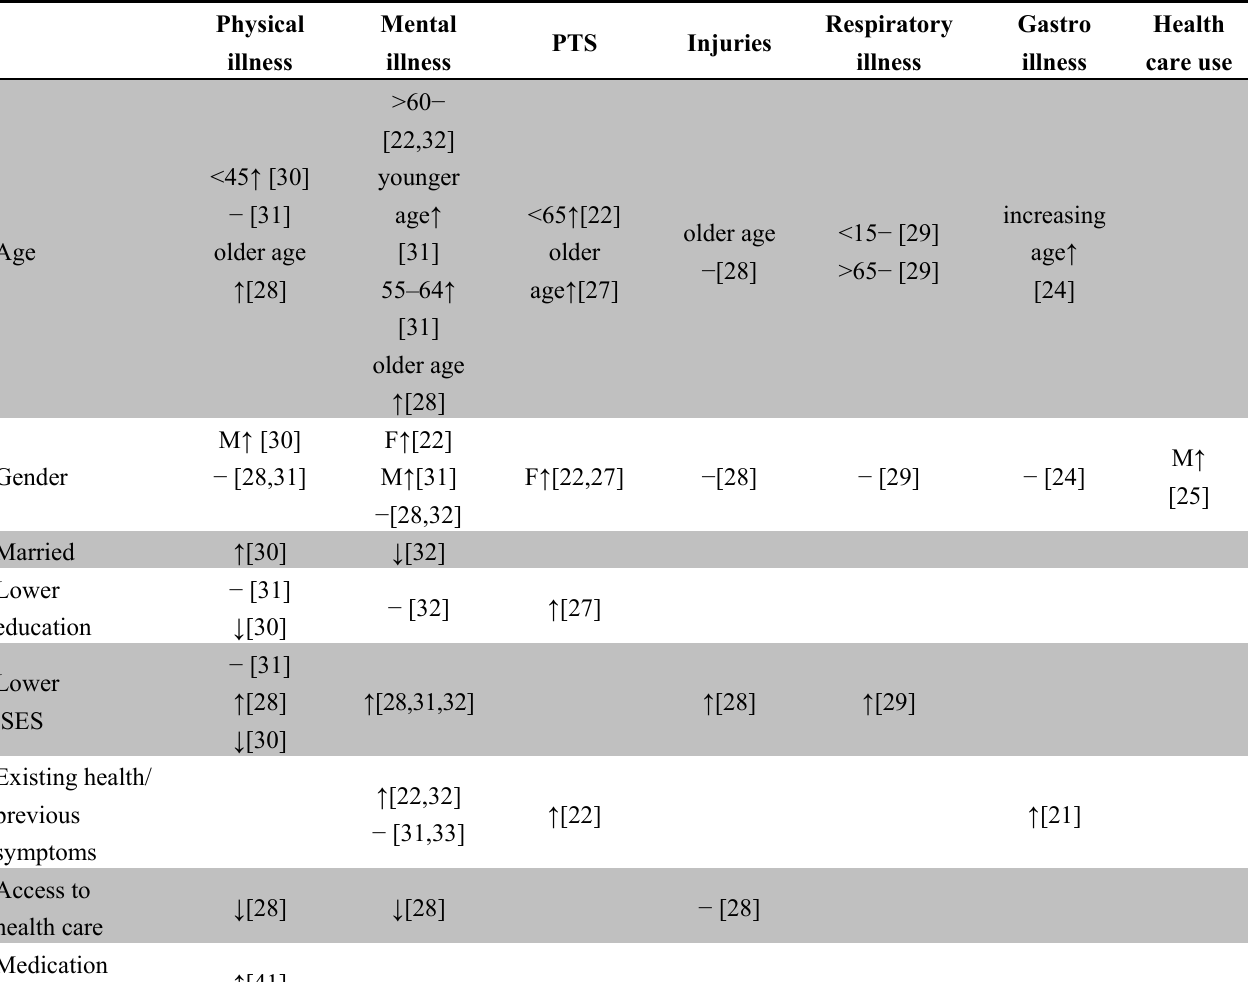
Table A6. Post-flood risk factors identified from studies that examined risk factors for those flooded in terms of health effects ( i.e. , answered research questions 1 and 3a). N.B. ↑ = risk factor; ↓ = protective factor; − = not significant; [x] indicates study reference